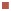
Impact of unintentional errors on model projections along the HIV care continuum.This figure shows the impact of unintentional errors on policy-relevant model projections for a complex model revision (Guideline-based ART). On the horizontal axis are five key steps along the HIV care continuum, while on the vertical axis are the projected estimates of the number in each step along the care continuum by 2023. Projections made by the error-free model are shown in blue, while model revisions with unintentional errors are shown in different shades of red, by model version (■ for Single Cell, ■ for Single Name, and ■ for Matrix).